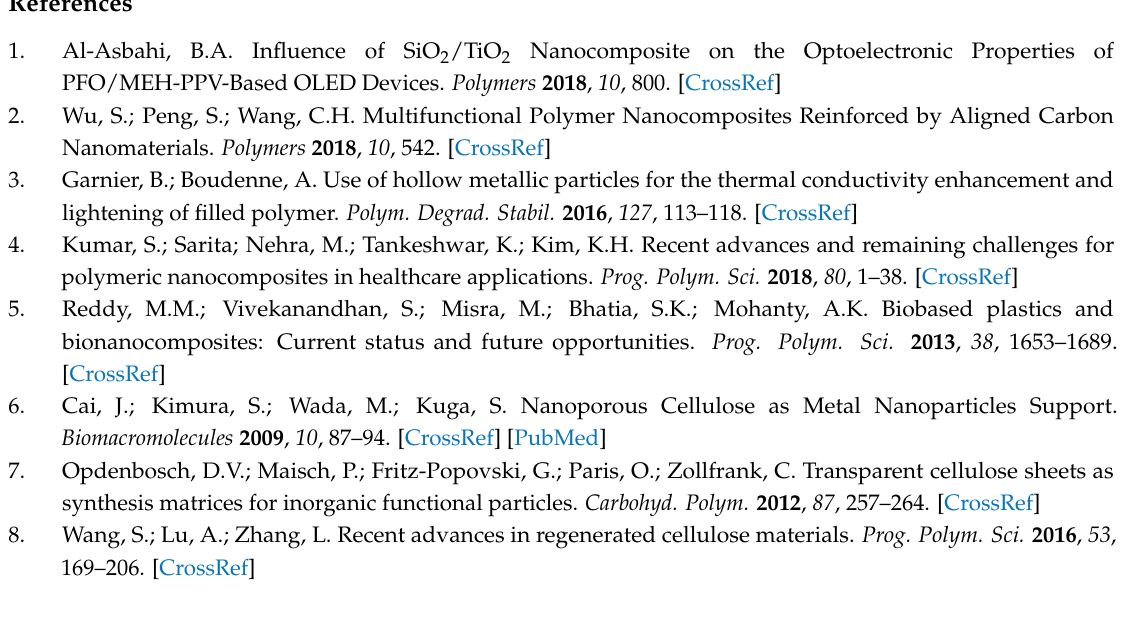
Figure 9. Static contact angle of the RC and RC/CeO 2 nanocomposite films.